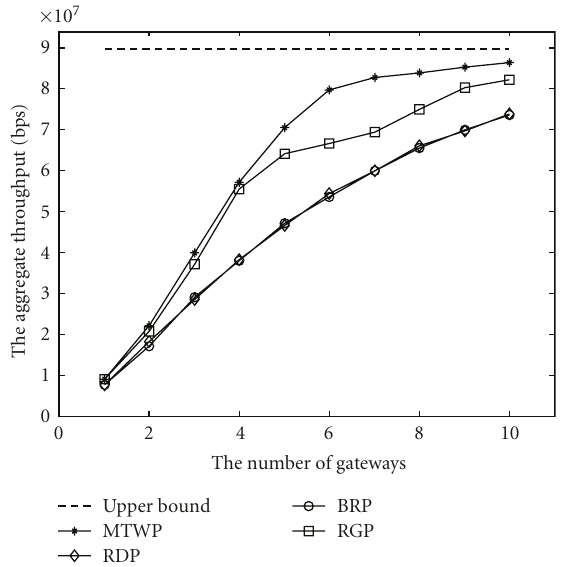
Figure 10: The comparison of the aggregate throughput with uniformly distributed mesh clients.